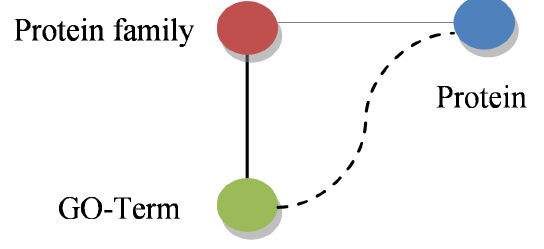
Figure 5: The dashed relation is created using the transitive